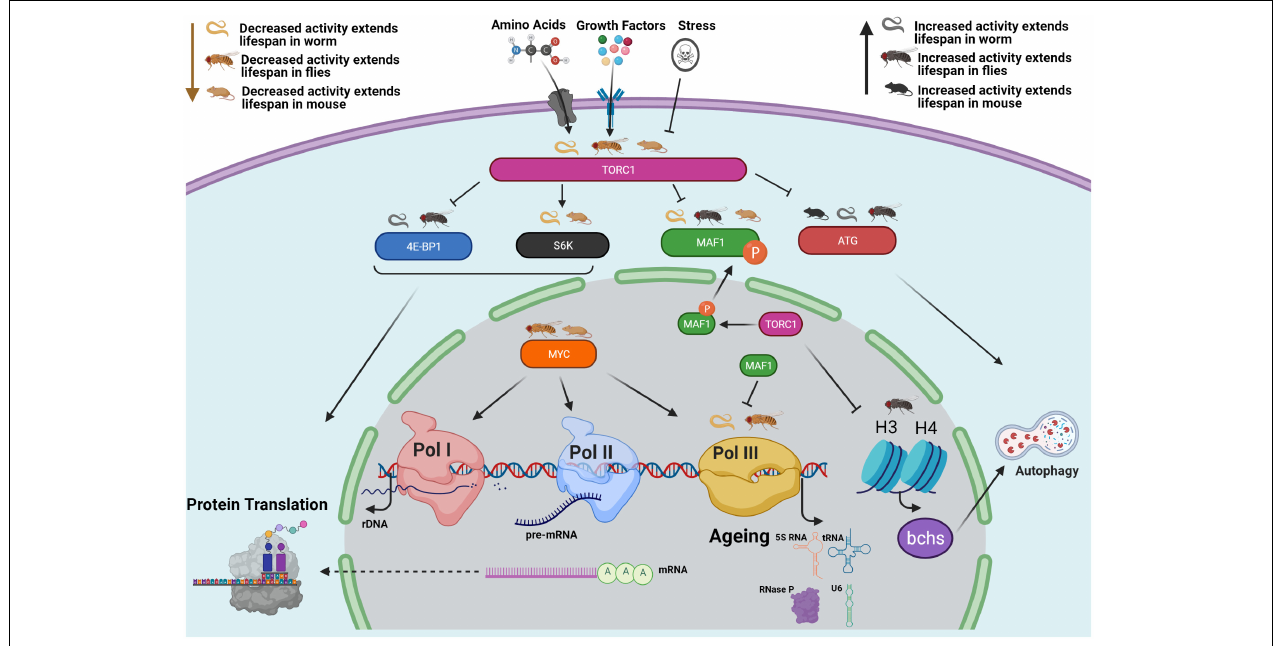
FIGURE 1 | Conserved relationships between TORC1, RNA Polymerase III and lifespan. The growth-promoting, anabolic functions mediated by Pol III activation represent at least one mechanism downstream of TORC1 that shortens adult health and survival (Filer et al., 2017). The “Odd Pols” Pol I and Pol III have also been implicated in disease states (Sharifi and Bierhoff, 2018; Zhang et al., 2018). TORC1 also controls the translational regulators S6 Kinase and 4E-BP1 as well as the autophagy regulators ATG1 and ULK1 (Liu and Sabatini, 2020), and the H3 H4 Axis (Lu et al., 2021). NB Histones H3/H4 regulate expression of an autophagy cargo adaptor Bchs (WDFY3 in mammals). Pol III is also regulated by MYC (as are Pol I and Pol II) which has also been implicated in the TORC1 pathway and in ageing (Gomez-Roman et al., 2003; Campbell and White, 2014; Hofmann et al., 2015; Zhao et al., 2019). This figure focuses on work in the worm, fly and mouse. Studies in these three model systems demonstrate that all of these TORC1 outputs can affect lifespan, as summarised here. As the structure and biochemical function of Pol III is well studied, it is possible to design inhibitors that may provide therapeutic effects (Abascal-Palacios et al., 2018; Girbig et al.,